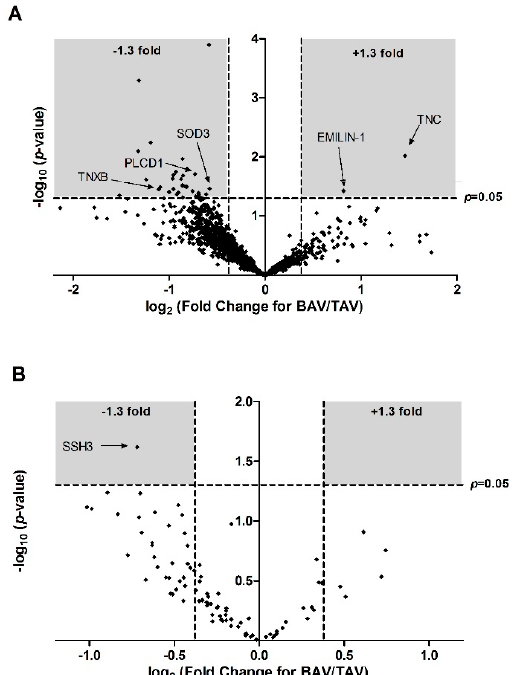
Figure 1. Volcano plot of proteins ( A ) and phosphoproteins ( B ) quantified in neonatal patients with bicuspid (BAV) verses patients with normal tricuspid (TAV). Each point represents the log 2 (fold change) between the groups plotted against the associated significance of this change. Proteins significantly altered (±1.3 fold change, p < 0.05) are shown in the grey shaded areas. TNXB: Tenascin-X; PLCD1: Phosphoinositide phospholipase C; SOD3: Extracellular superoxide dismutase 3; EMILIN-1: elastin microfibril interfacer 1; TNC: Tenascin C; SSH3: Protein phosphatase slingshot homolog 3; BAV: bicuspid aortic valve; TAV: tricuspid aortic